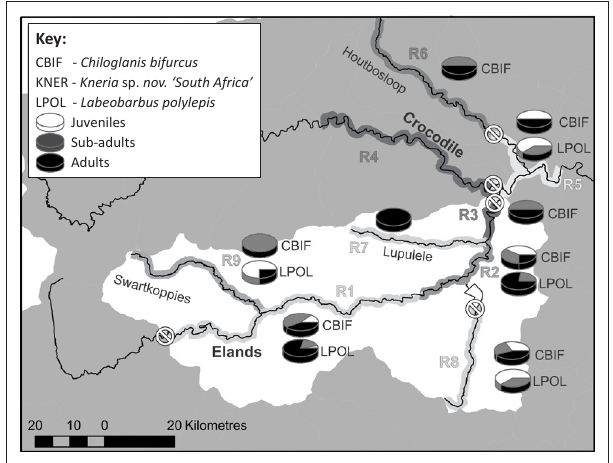
FIGURE 2: Population structure of Chiloglanis bifurcus and Labeobarbus polylepis from each site considered in the study. Charts present percentage proportions of juveniles, sub-adults and adults.